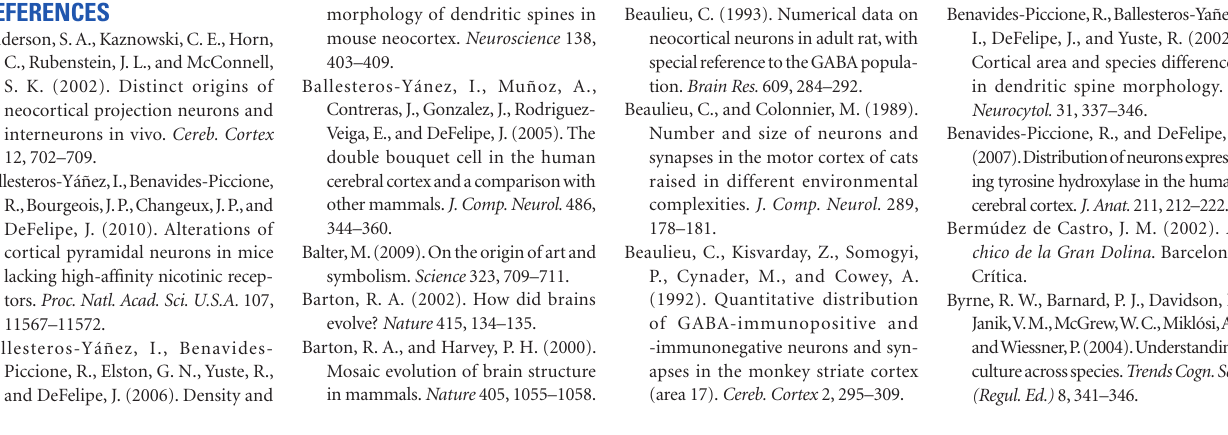
Figure 17 | Tyrosine hydroxylase interneurons. Low-power photomicrographs of tyrosine hydroxylase (TH) immunostaining in the temporal cortex of the human (anterolateral temporal lobe) (A) , macaque (area TE) (B) , somatosensory cortex of the gerbil (C) , and somatosensory cortex of rat (D) , extending from lower part of layer V to the white matter. Some TH neurons are indicated with arrows. TH neurons are relatively